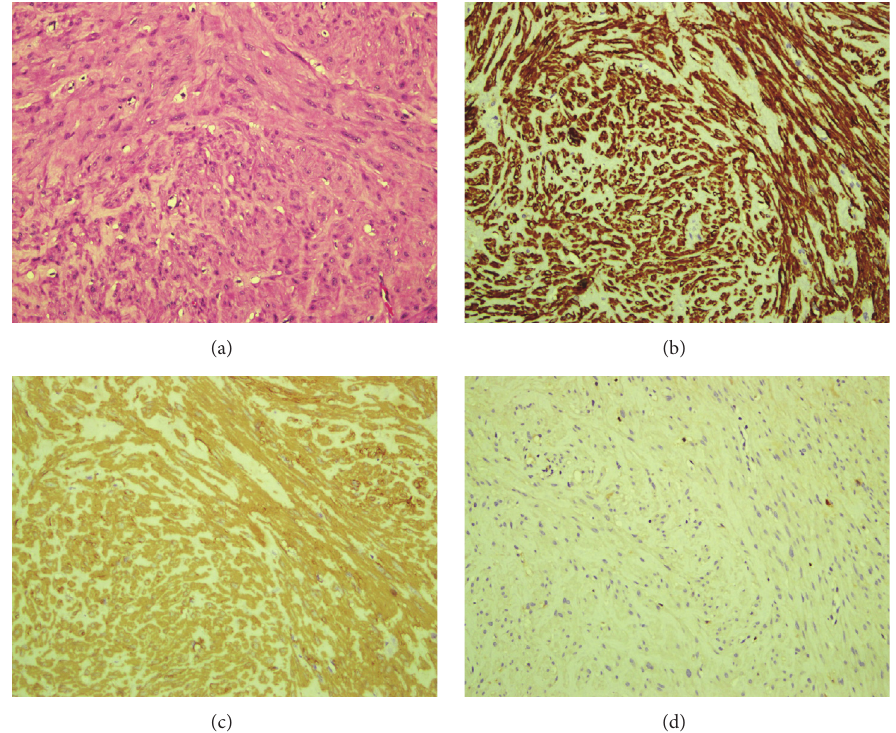
Figure 2: (a) HE 200x. Section shows a well-circumscribed tumour comprising interlacing bundles of smooth muscle fibres displaying uniform spindle-shaped nuclei. Immunohistochemical study shows the cells are positive for SMA (b) and desmin (c). They are negative for S-100